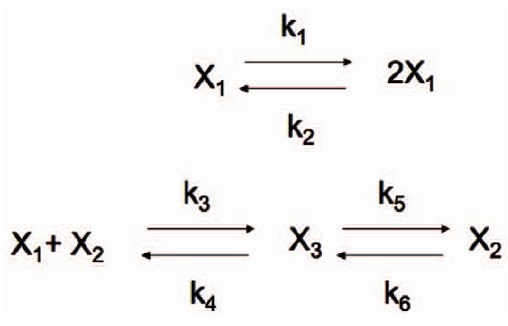
Figure 1. Edelstein chemical reaction network scheme. X 1 ~ A , X 2 ~ B , X 3 ~ C .